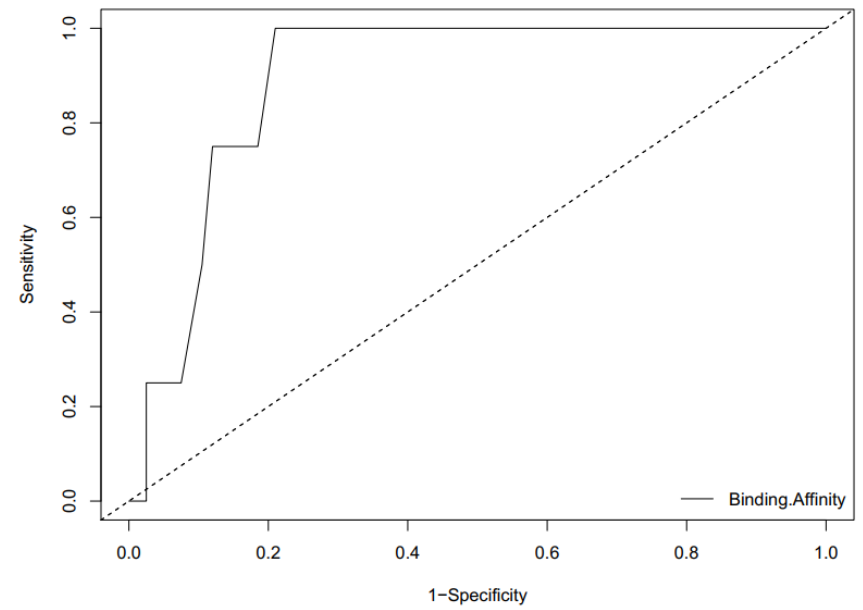
Figure 8. An ROC curve generated by screening co-crystalized ligands from ICL of M. tuberculosis with corresponding decoys against the model structure of ICL of M. ulcerans . The AUC of the ROC curve is 0.89375, which is considered reasonably good.